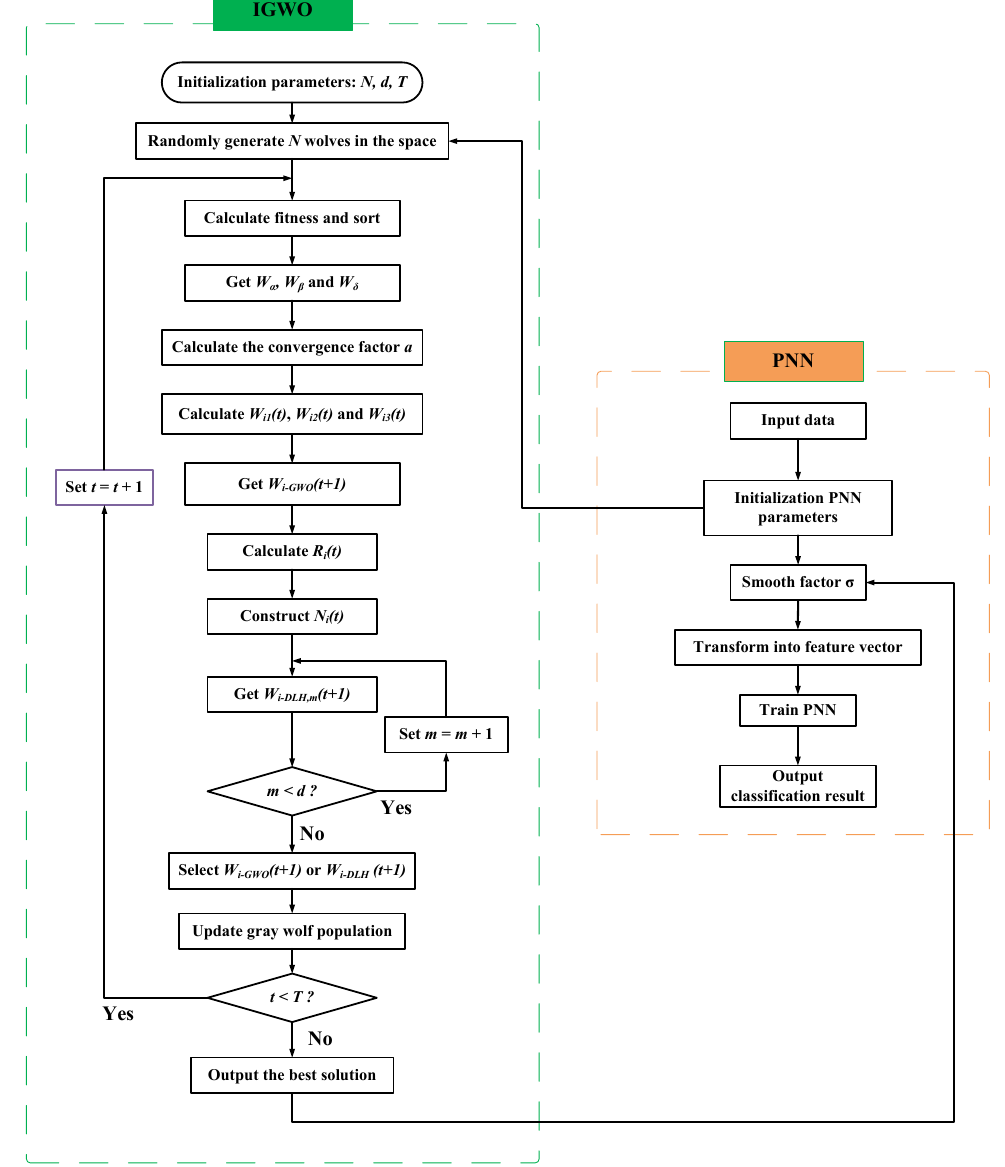
Figure 2. Flow chart of